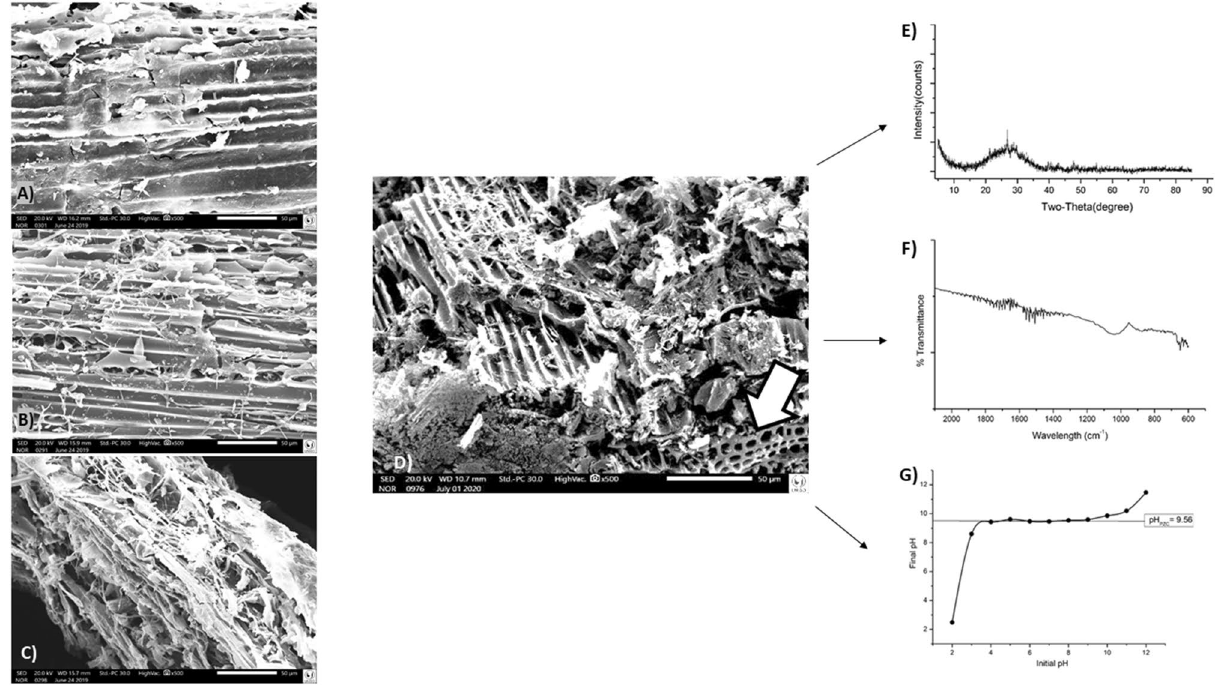
Figure 1. Images of scanning electron microscopy of Spent Mushroom Substrate (SMS), before pyrolysis ( A ). Biochar from SMS after pyrolysis at ( B ) 250 °C, ( C ) 450 °C and ( D ) 600 °C. In ( E ) X-ray diffraction patterns